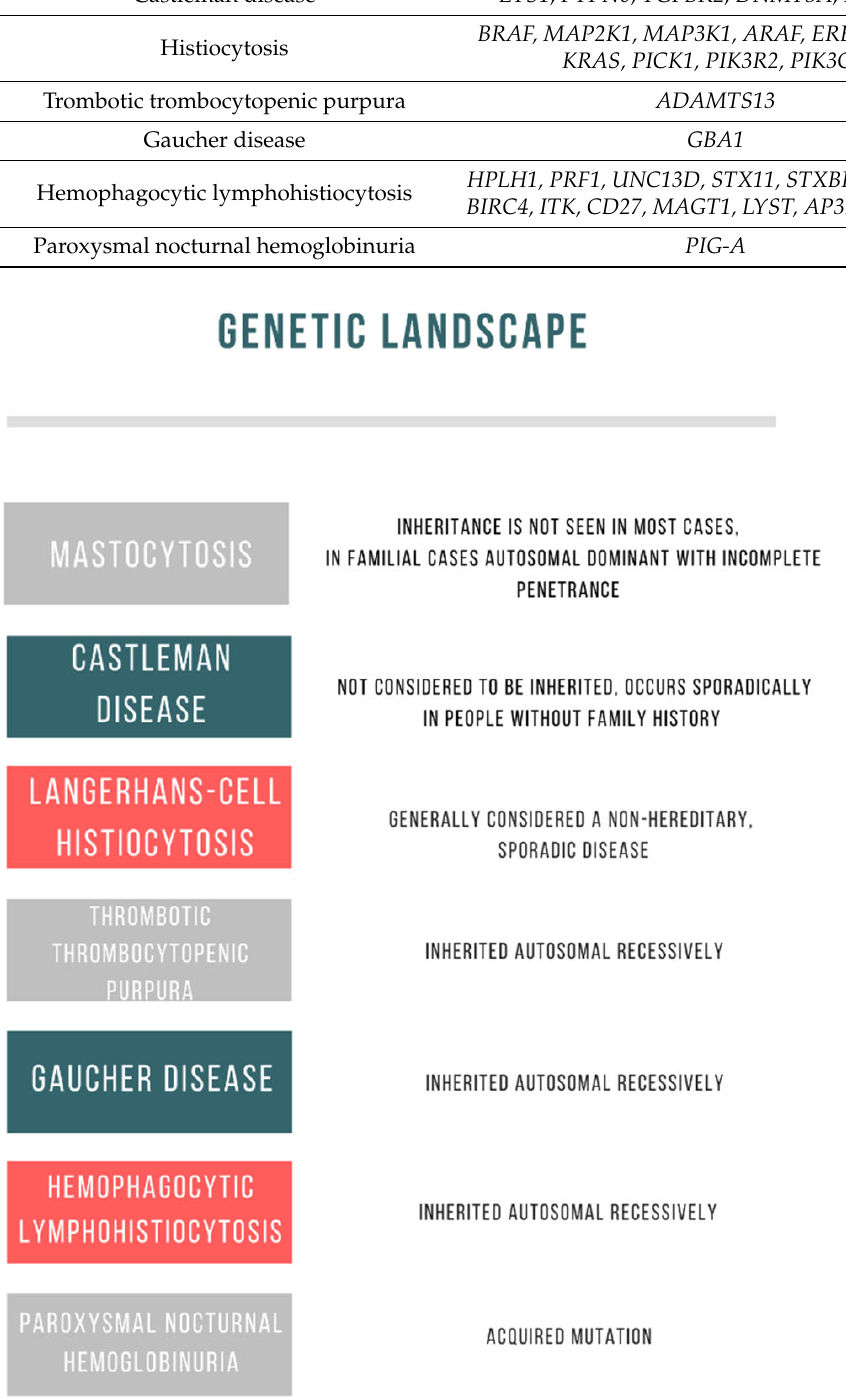
Figure 2. Genetic causes of rare diseases in pediatric hematology.